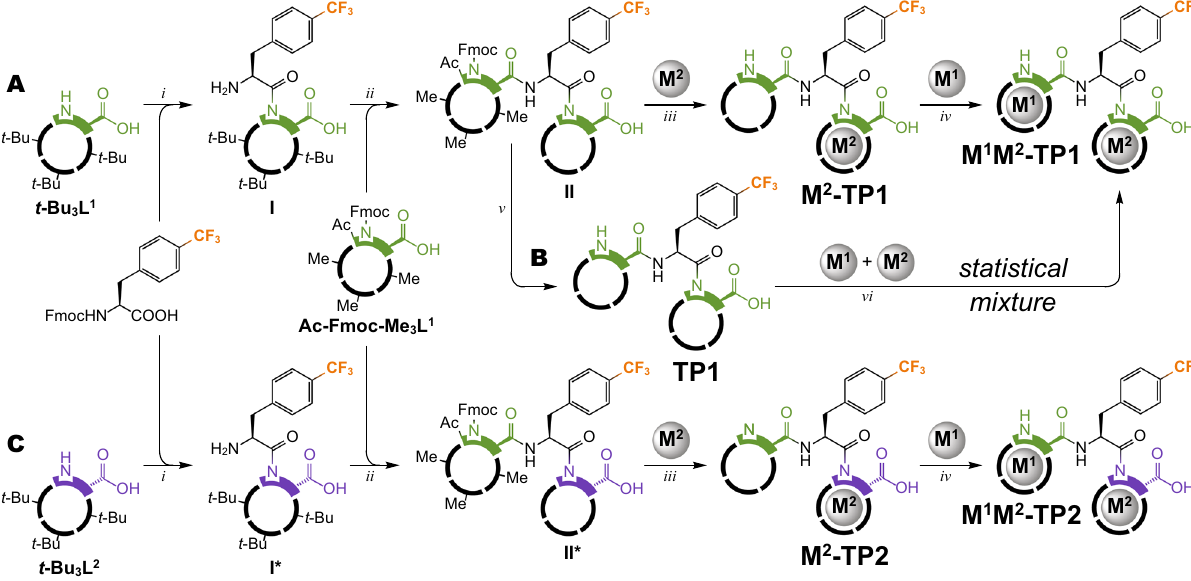
Fig. 5 Synthesis of M 1 M 2 -TP1 and M 1 M 2 -TP2 compounds. A Main synthetic pathway to well-de fi ned M 1 M 2 -TP1 products. B Post-synthetic complexation pathway to statistical mixtures of four major M 1 M 2 -TP1 products. C Synthetic pathway to well-de fi ned M 1 M 2 -TP2 products (analogous to A). Conditions: (i) Fmoc-Phe{ p -CF 3 }-OH, PyAOP (( 7 -azabenzotriazol- 1 -yloxy)tripyrrolidinophosphonium hexa fl uorophosphate), DIPEA ( N , N -diisopropylethylamine), DMSO (dimethyl sulfoxide) followed by DBU ( 1 , 8 -diazabicyclo[5.4.0]undec- 7 -ene), DMF (dimethylformamide); (ii) Ac-Fmoc-Me 3 L 1 , PyAOP, DIPEA, DMSO followed by TFA (tri fl uoroacetic acid); (iii) M 2 Cl 3 , aq. MOPS ( 3 -( N -morpholino)propanesulfonic acid)/NaOH (pH 7.0) followed by LiOH, H 2 O, MeOH; (iv) M 1 Cl 3 , aq. MOPS/NaOH (pH 7.0); (v) LiOH, H 2 O, MeOH; (vi) M 1 Cl 3 , M 2 Cl 3 , aq. MOPS/NaOH (pH 7.0). For the full structures of the